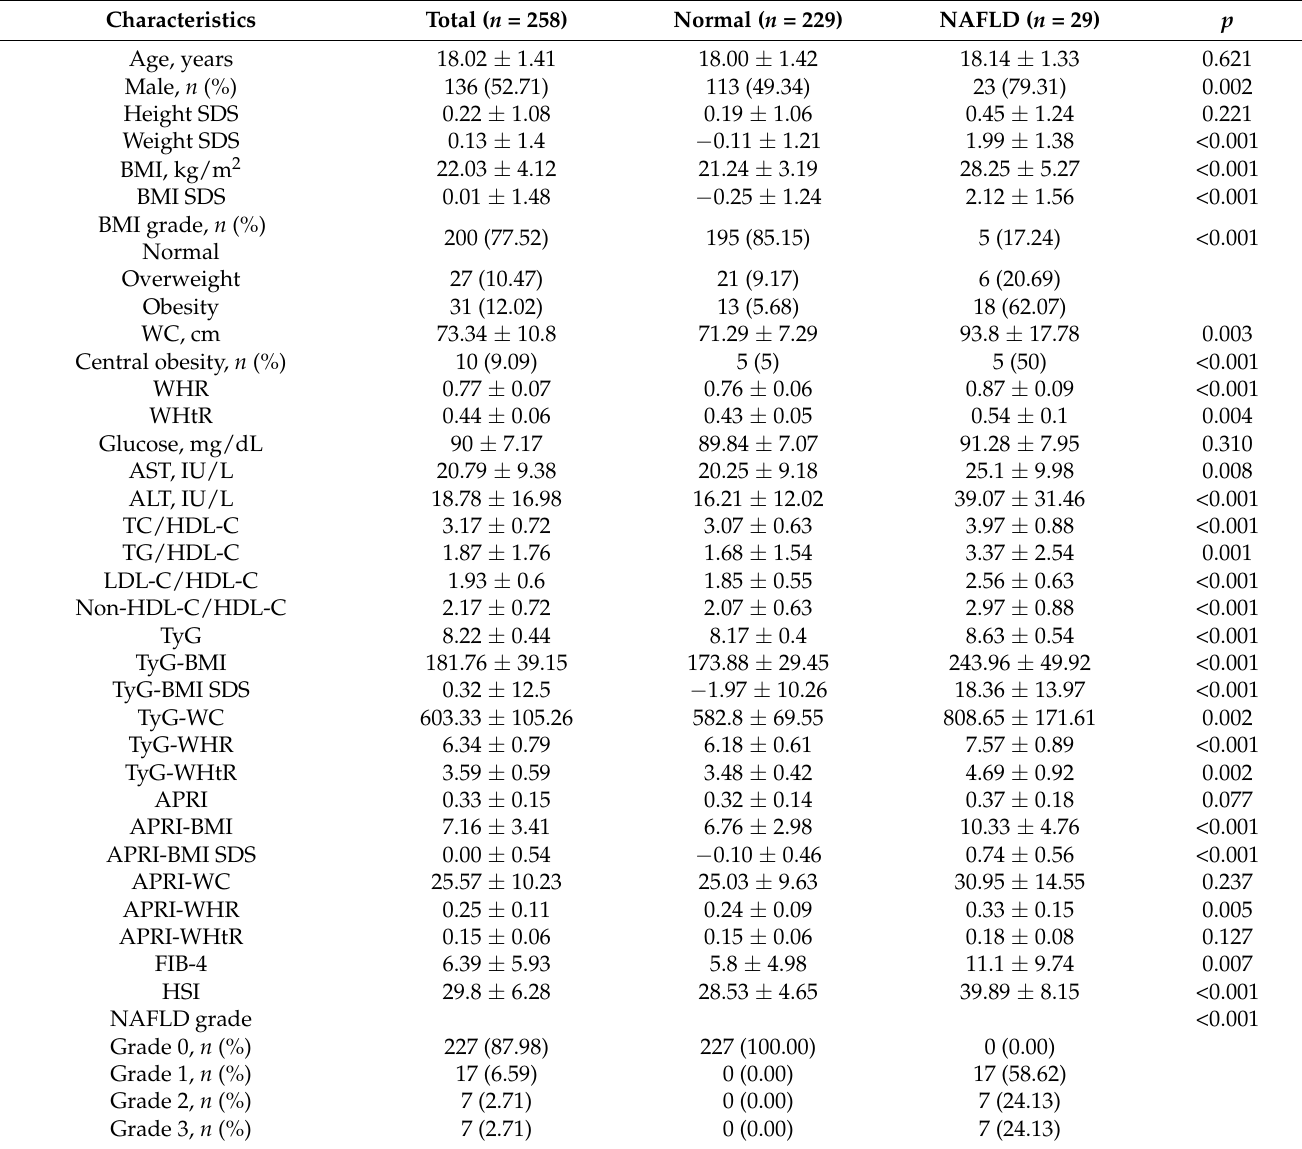
Table 1. Characteristics of participants according to